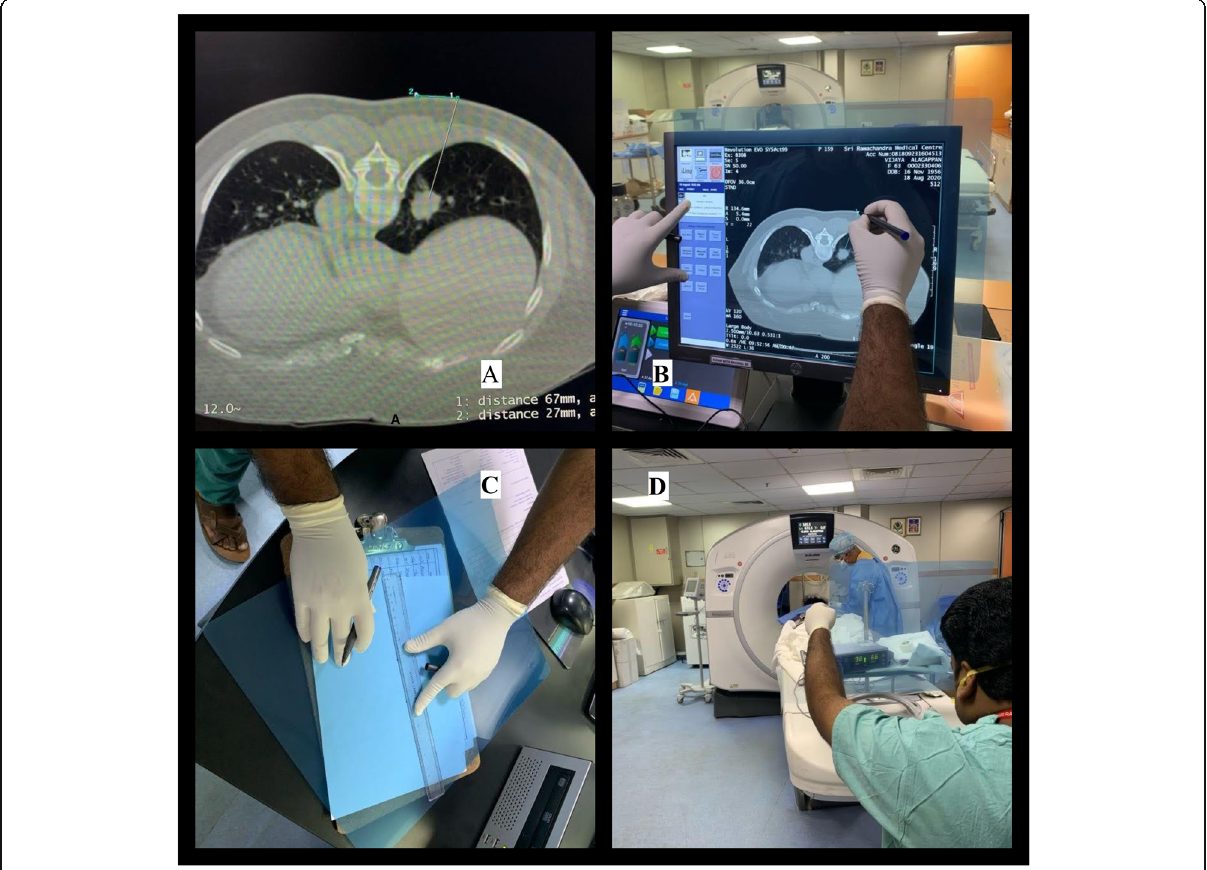
Fig. 2 a Distance between the point of entry and target region is measured. b The point of entry and the target region are marked in a transparent sheet against the monitor. c Draw a line joining these two points. d An assistant holding the transparent sheet from the foot